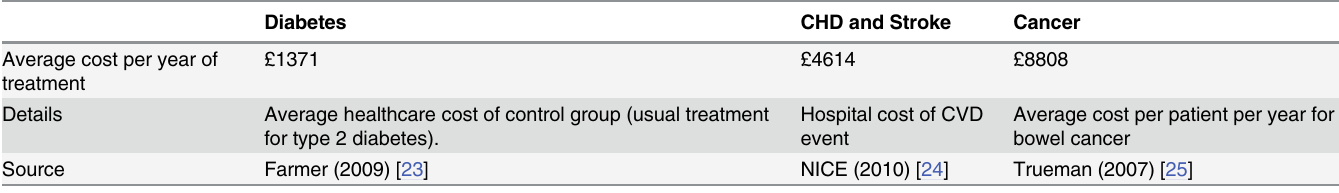
Table 3. Annual cost of diseases used in